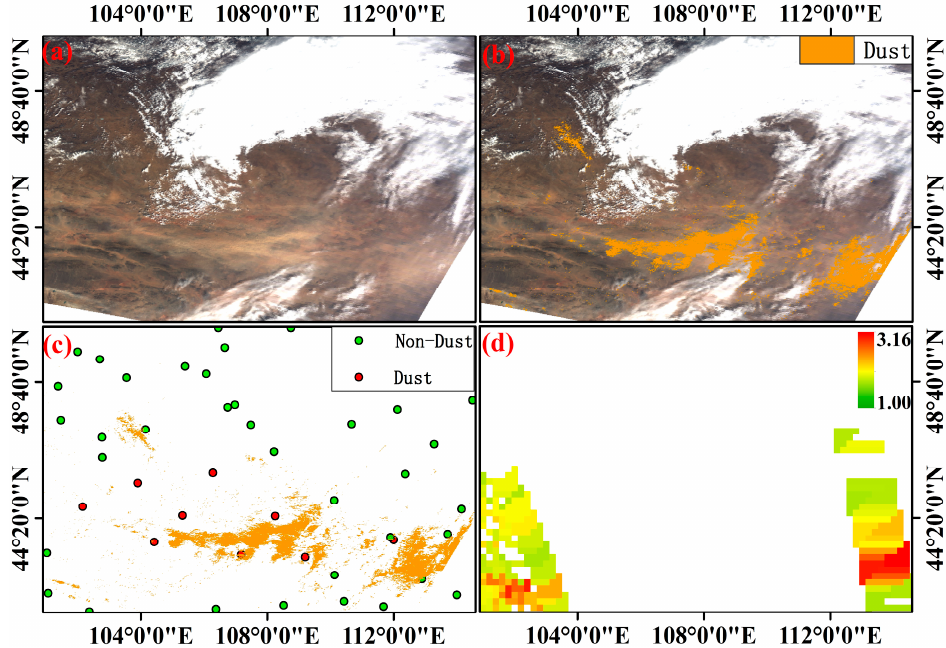
Figure 4. Comparison between the dust storm monitoring result (b), MODIS RGB image (a), MICAPS data (c), and OMI AI data (d) on 27 March, 2015. Remote Sens.2019, 5, x FOR PEER REVIEW